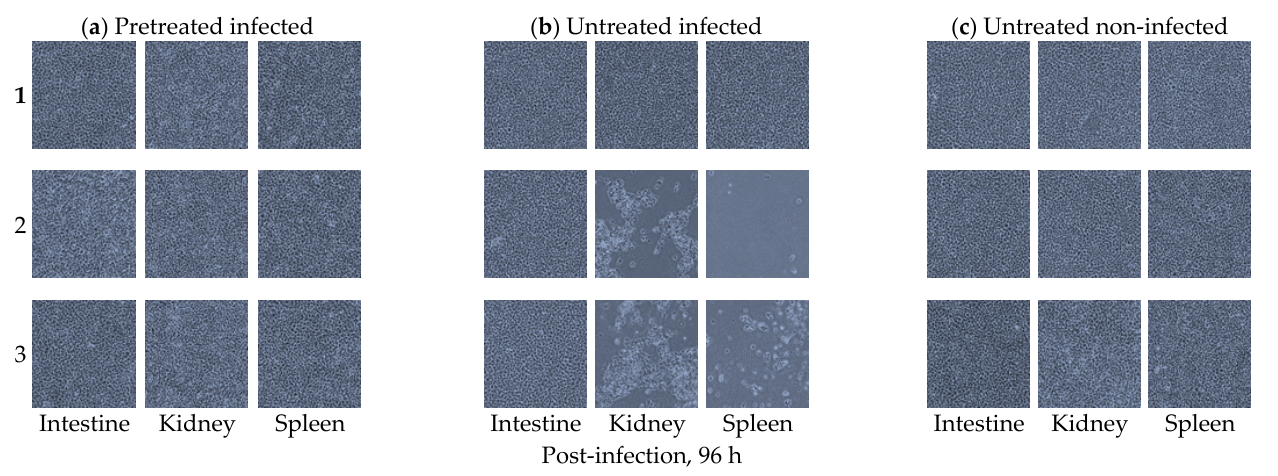
Figure 5. Intestinal epithelial cells (IECs), intestine, kidney, and spleen tissues cultured from olive flounder ( Paralichthys olivaceus ). ( a ) Replicates of intestine, kidney, and spleen homogenates cultured in EPC cells from the orally B. subtilis - pretreated olive flounder at a concentration of 10 6 CFU/mL examined 96 h after the VHSV infection. Note the absence of cytopathic effects (CPE) in all the tissues examined. ( b ) Replicates of intestine, kidney, and spleen homogenates cultured in EPCs from the B. subtilis -untreated olive flounder examined 96 h after the VHSV infection. Note the presence of CPE in two cases of the EPC cells inoculated with spleen and kidney samples and the absence of CPE in all intestine replicates. ( c ) Replicates of intestine, kidney, and spleen homogenates cultured in EPC cells from B. subtilis -untreated olive flounder that were not infected by VHSV examined after 96 h. Note the absence of CPE in all the tissues examined. All images were visualized by phase-contrast microscopy at 100× magnification.